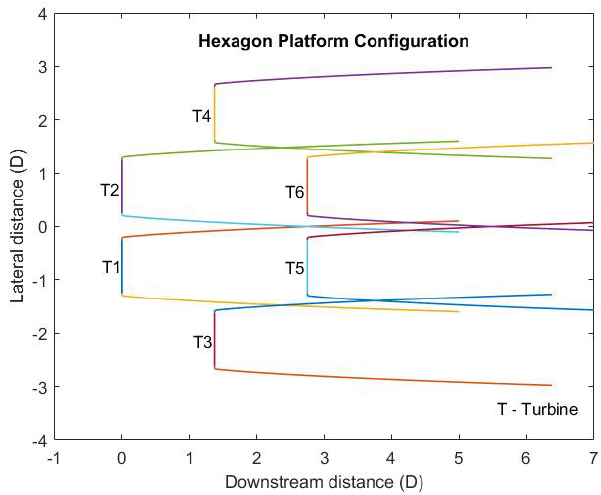
Figure 3. Wake propagation for a hexagon platform.